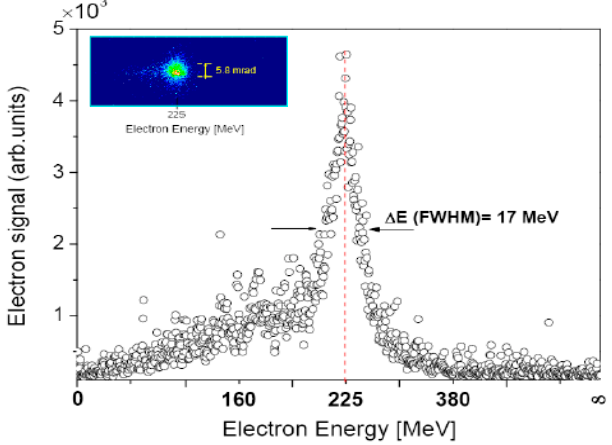
Figure 16. Quasi-monoenergetic 225 MeV electron beam with a width of 17 MeV generated in a 4 mm long gas jet at a density of 7 × 10 18 cm − 3 when irradiated with a 27 TW laser pulse [83]. Reproduced from [83]. Copyright 2009, AIP Publishing